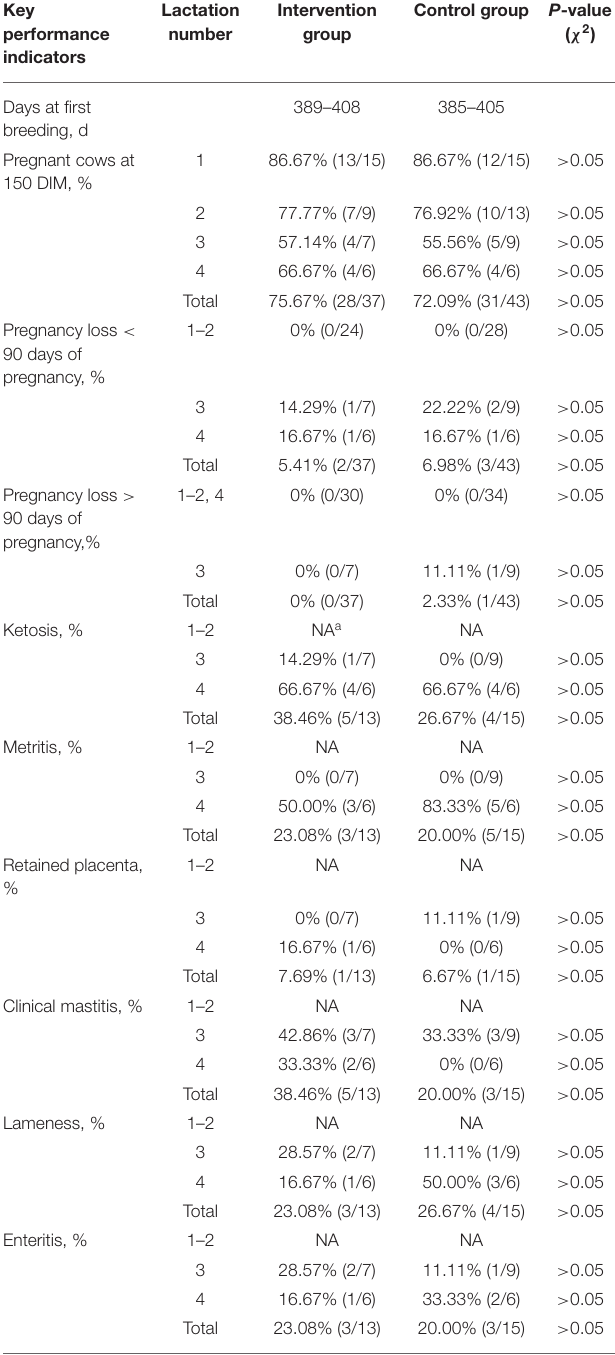
TABLE 2 | Comparison of four key performance indicators and the incidences of six common diseases between the intervention and control